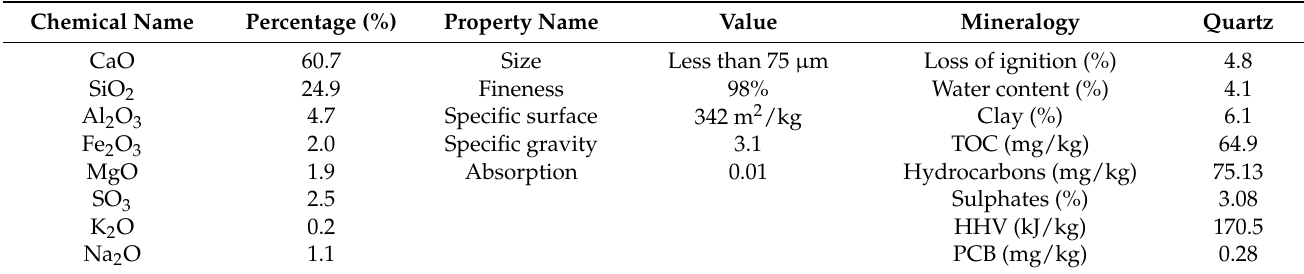
Table 2. Properties of waste glass.